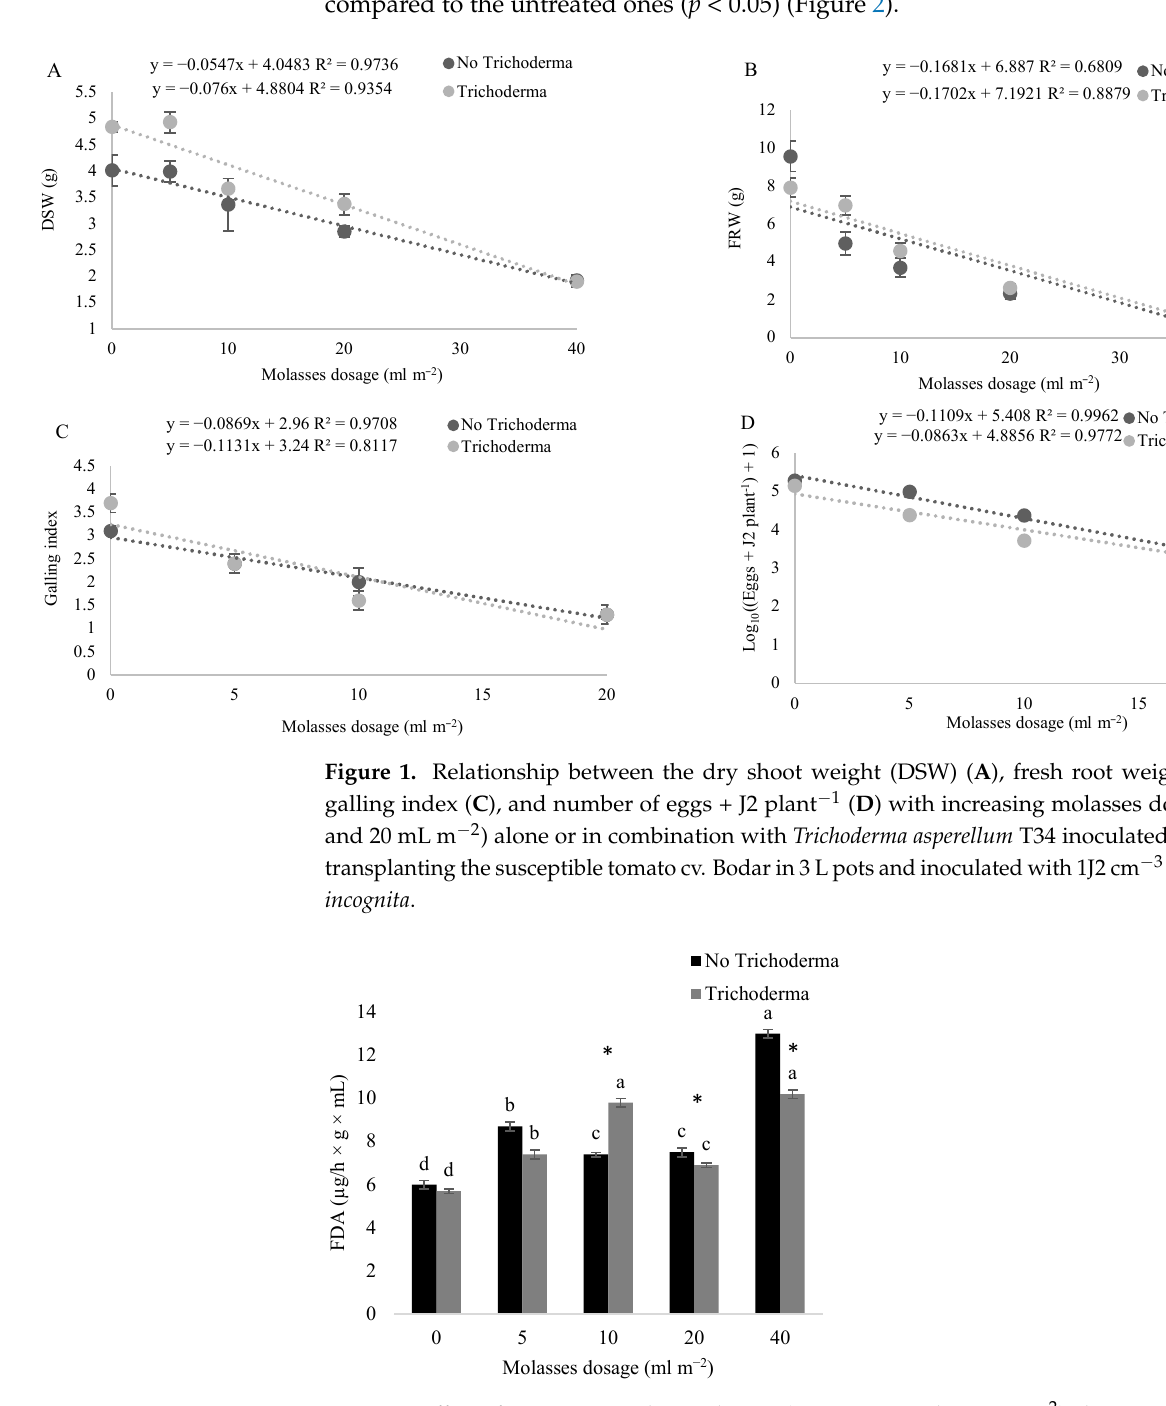
Figure 2. Effect of increasing molasses dosage (0, 5, 10, 20, and 40 mL m −2 ) alone or in combination with Trichoderma asperellum T34 inoculated before and at transplanting the susceptible tomato cv. Bodar in 3 L pots and inoculated with 1J2 cm −3 of Meloidogyne incognita on the soil microbial activity (FDA). Data are presented as mean ± standard error of 10 repetitions. Data of the different dosages followed by different letters and between Trichoderma applications followed by * indicates differences according to the Krustal–Wallis test or the Wilcoxon rank test, respectively ( p < 0.05). In the field experiments, the disease severity and nematode reproduction in tomato plants grown at Castellbisbal in plots treated with molasses at a rate of 10 mL m −2 alone were significantly lower ( p < 0.05) in comparison with the untreated control, but not when combined with T34 Biocontrol. However, in the lettuce crop, the nematode significantly reproduced less ( p < 0.05) in the molasses alone- or combined with T34 Biocontrol-treated plots than in the untreated control ones (Table 5). Significantly lower ( p < 0.05) soil micro- bial activity was recorded at the beginning of the experiment in the untreated control plots, but did not differ ( p < 0.05) between treatments at the end of the lettuce crop (Figure 3). At Martorell, the application of molasses alone or combined with T34 Biocontrol did not affect ( p < 0.05) the disease severity and nematode reproduction in either tomato or